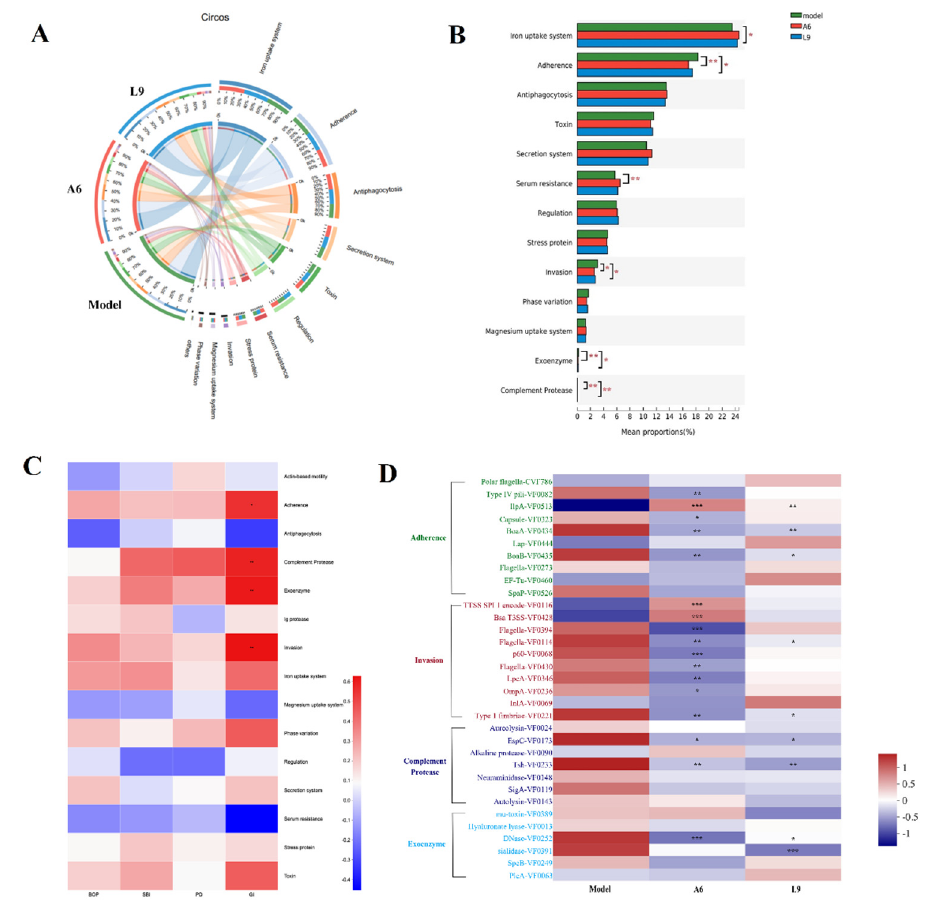
Figure 7. Effects of A6 or L9 administration on species virulence factor functions in PD-model mice. ( A ) The sample and species function Circos diagram shows the abundance correspondence between sample and virulence factor function. ( B ) Multigroup comparison diagram of virulence factor function depicting the significance of the functional abundances of virulence factors among different groups. ( C ) Correlation heatmap showing four clinical PD indices and species virulence factor functions. ( D ) Comparison of top 10 virulence factor differences in adherence, invasion, exoenzyme, and complement protease functions (* indicates the differences between probiotic and model groups; * p < 0.05, ** p < 0.01, *** p < 0.001).